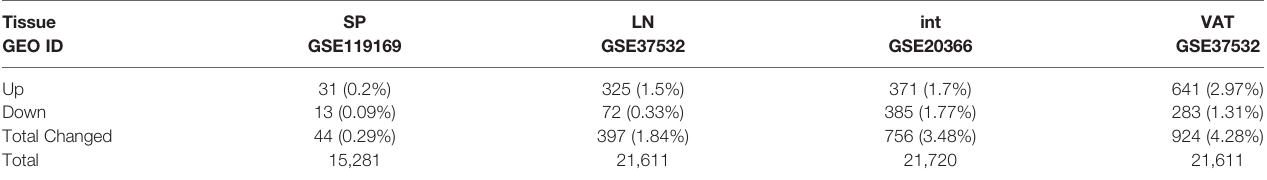
TABLE 3 | Overall changes in the comparison of regulatory T cells (Treg) versus conventional T cells (Tconv) in different tissues showed that Treg can be modulated more signi fi cantly by the microenvironment in different peripheral tissues than Tconv, by which we can de fi ned the tiers of the tissues. Tissue